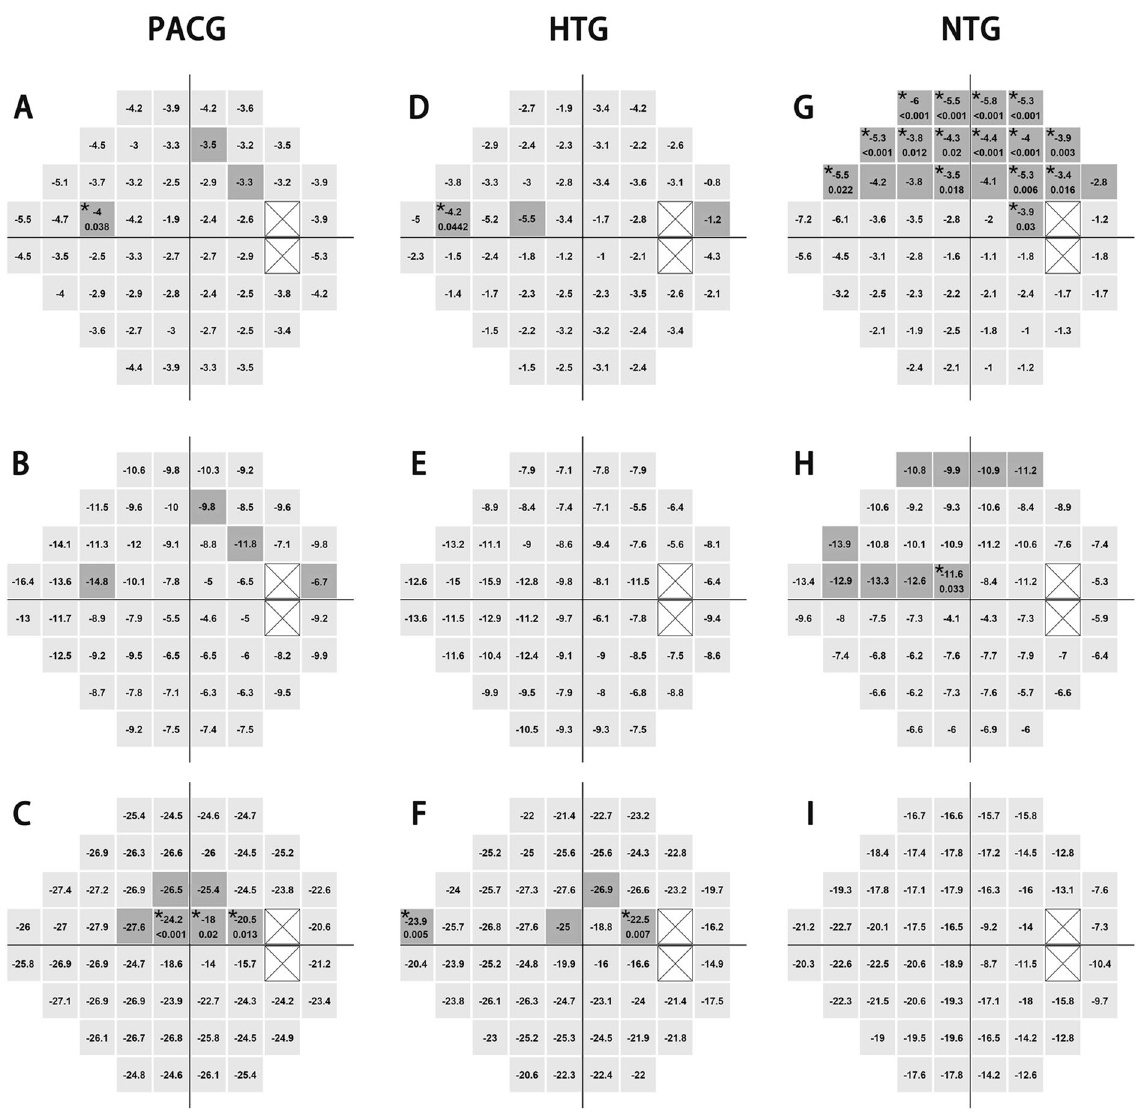
Figure 2. Between-hemifield comparisons of pointwise locations across severity levels. (A–C) show the patterns of visual field defects in the PACG group. (D–F) show the HTG group, (G–I) show the NTG group; (A,D,G) represent early stages; (B,E,H) represent moderate stages, and (C,F,I) represent advanced stages. The dark-shadow points indicate significantly worse TD values than their corresponding locations in the inferior hemifield (P < 0.05) and asterisks indicate significant points after Bonferoni correction. Image was generated using “R” software (R version 4.0.2, http:// www.r- proje ct. region in advanced-stage PACG eyes had significantly worse VF damage in the superior hemifield than in the inferior hemifield. In HTG eyes in the current study, the central region in the early stage and the central and paracentral regions in the advanced stage had significantly greater damage in the superior hemifield than in the inferior hemifield. This result is similar to that in the report by Gazzard and associates 23 , who compared the characteristics of VF defects between HTG and PACG eyes. Their early-stage HTG eyes had significantly lower sensitivity in the paracentral region of the superior hemifield than in the inferior hemifield; advanced-stage HTG eyes had sig- nificantly lower sensitivity in the superior central region. In early-stage and advanced-stage HTG eyes in both Gazzard et al 23 and the current study, only the central and paracentral regions in the superior hemifield were more damaged than the corresponding regions in the inferior hemifield. However, in a previous study conducted by Yousefi et al 32 , almost all superior GHT regions had significantly worse VF damage than the corresponding inferior regions in Japanese POAG patients. The main reason for the discordant intraocular asymmetric VF defect patterns among these studies is likely the different criteria used in defining POAG. In Yousefi’s 32 study, POAG was defined as the presence of glaucomatous optic neuropathy with an open anterior chamber angle, while IOP was not a diagnostic criterion. The proportion of NTG among POAG cases in the Japanese population is as high